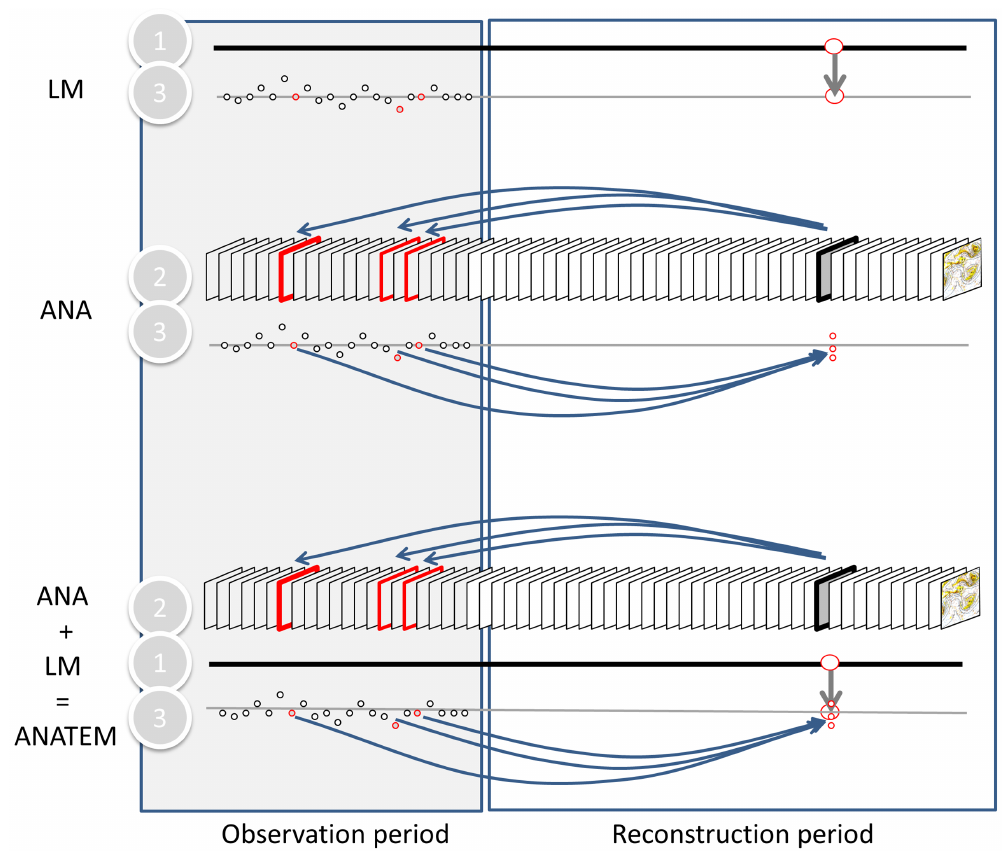
Figure 1. Schemes of the three reconstruction models: local model (LM – top scheme), analogue model (ANA – middle scheme), com- bined local+analogue model (ANATEM – bottom scheme). Predictors are either (1) local-scale meteorological predictors (LM model), (2) mesoscale atmospheric predictors (ANA model) or both (1)+(2) (ANATEM model). Local-scale predictors are daily observations of the variable at one (possibly several) neighbouring precipitation or temperature station (for the present work, Gap rain gauge, Marseille tem- perature station for precipitation/temperature reconstruction respectively). Mesoscale predictors are fields of atmospheric variables (700 and 1000hPa geopotential heights over a mesoscale European domain). Local and mesoscale predictors cover the whole period (observa- tion+reconstruction). The three reconstruction models are first developed and evaluated based on their reconstruction skill for the observation period where concomitant observations of the target variable are available (dots of series 3 in the scheme, period 1948–2010 in the present work). Models are next applied for the reconstruction of each day of the reconstruction period (period 1883–2010 in the present work). Note: the reconstruction period can also include the observation period (this is the case in the present